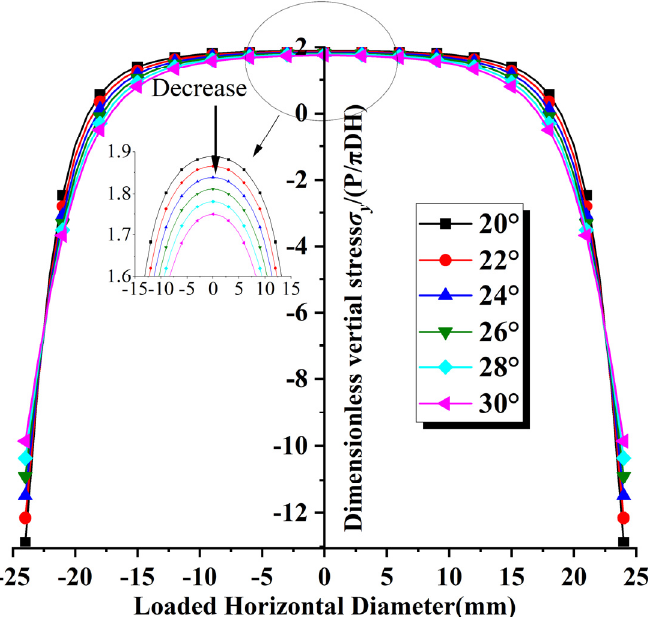
Figure 7. Non-dimensional vertical stresses along loaded diameter. Table 2. Ratios of non-dimensional compressive stress to tensile stress inside discs.